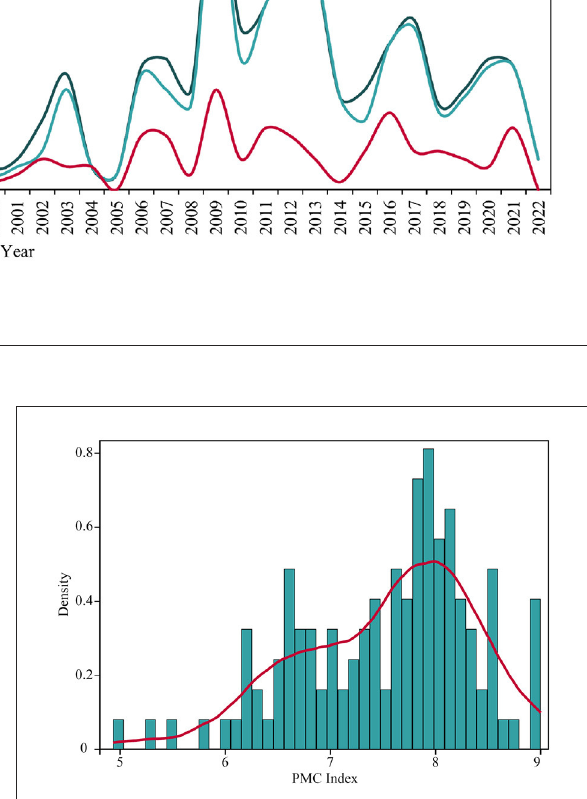
FIGURE3 The kernel density curve of PMC index values of 121 TCMDPs. Bin = 40, start = 4.933, bandwidth = 0.102; the kernel density was estimated by the Epanechnikov